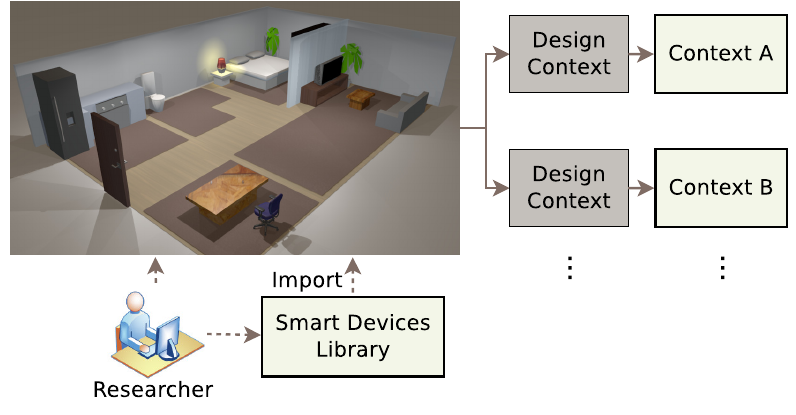
Figure 2. The design